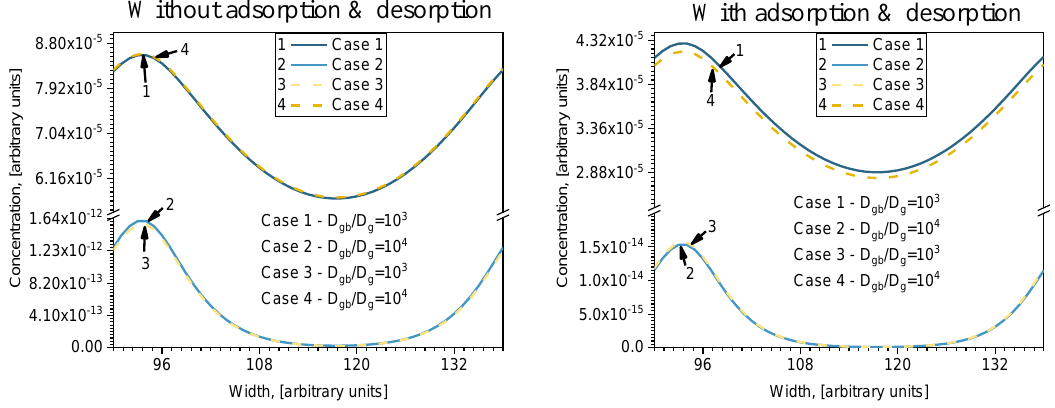
Figure 5. Parallel to the surface concentration profiles for ( b ) model (see Figure 2) at depth i = 141 a.u: at left side without adsorption/desorption and at right side with adsorption and desorption.